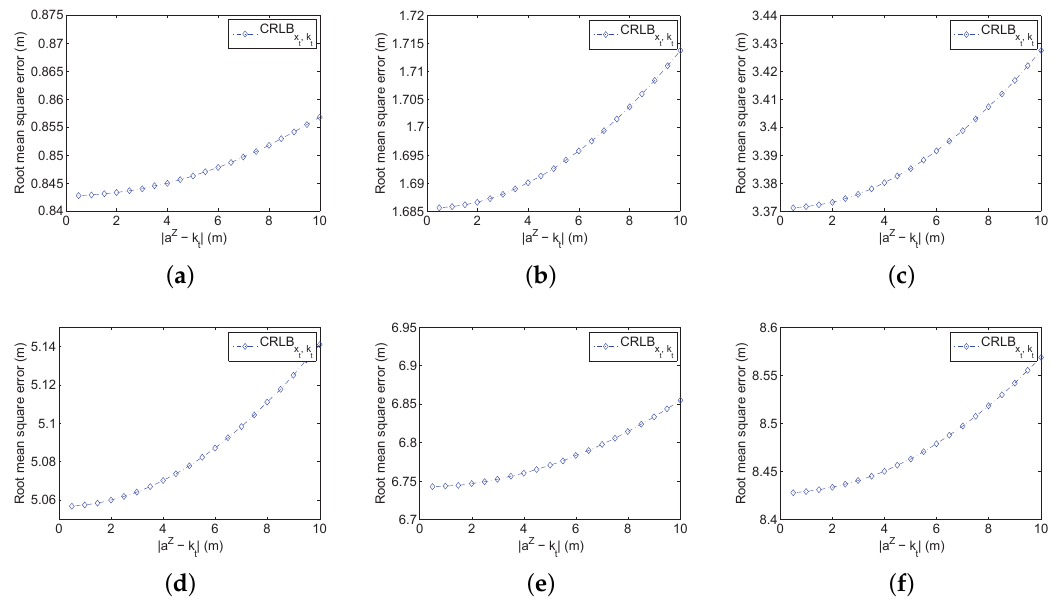
∼ N ( 0,1 2 ) ; ( c ) v j t